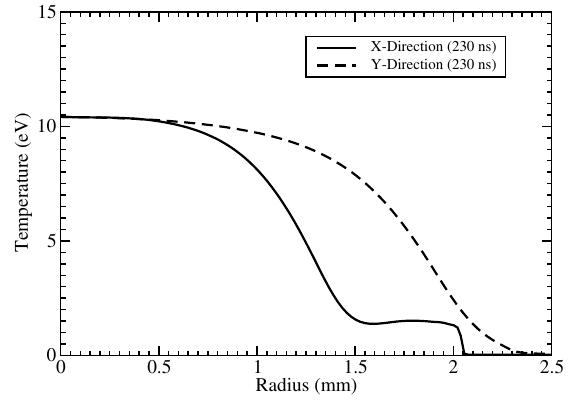
FIG. 25. Same as in Fig. 23, but at t (cid:3) 230 ns .